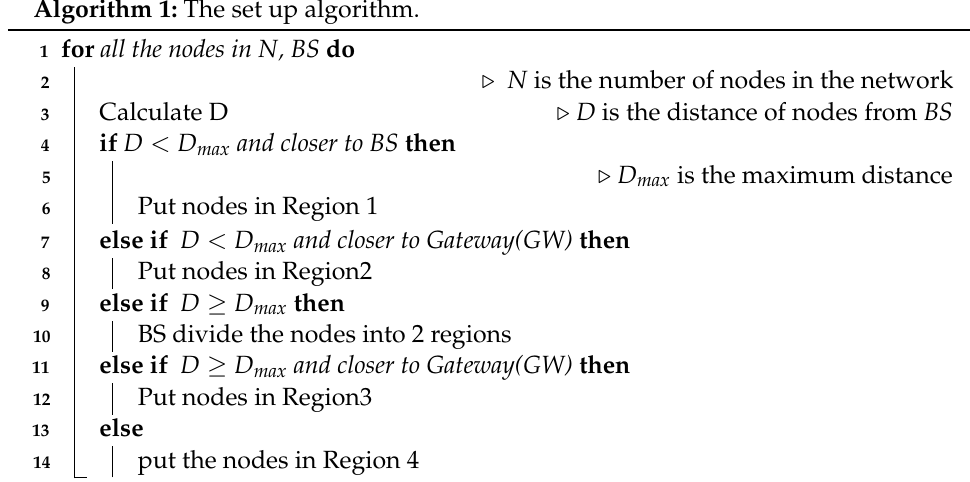
Algorithm 1: The set up